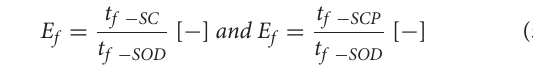
value for each turbo roundabout. The passenger car